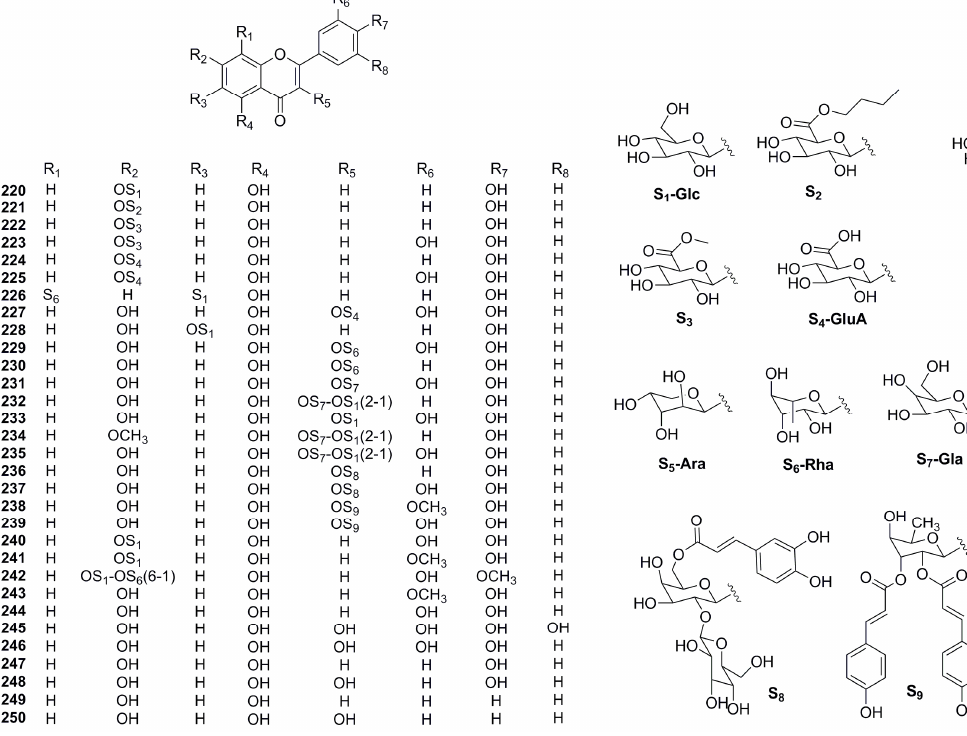
Figure 5. Chemical structures of flavonoidsand their glycosides.